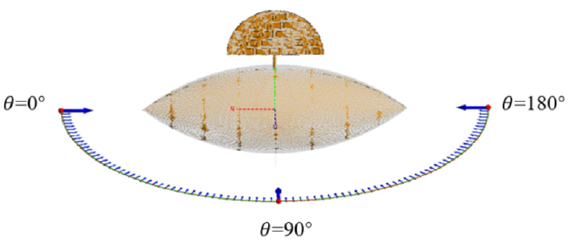
Figure 10. The schematic of incident wave.